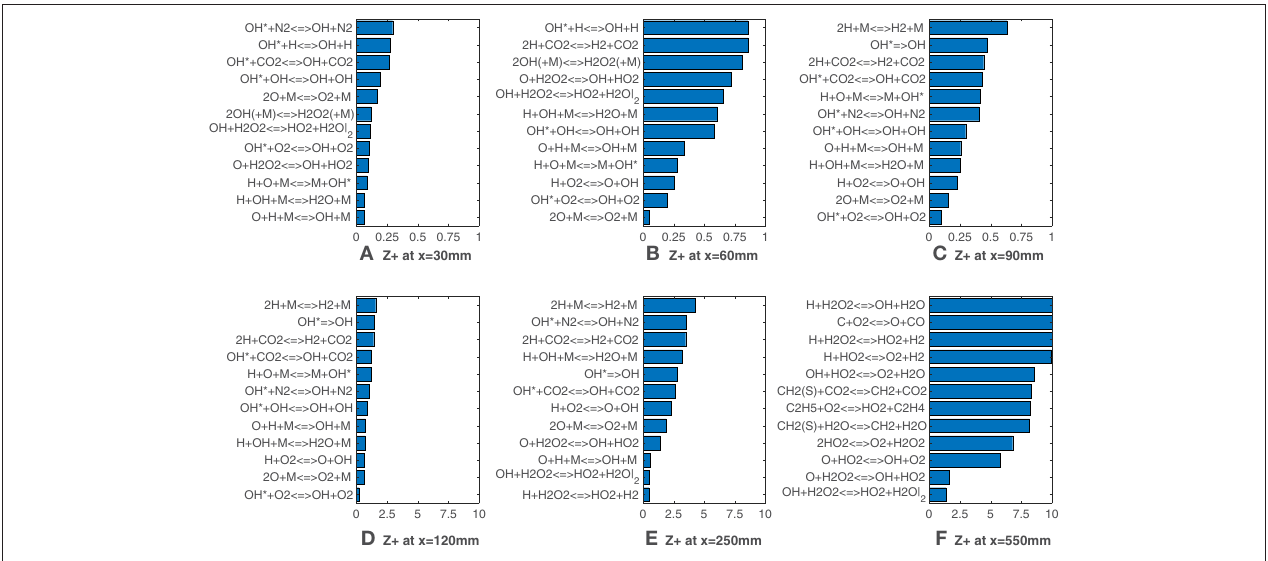
FIGURE 6 | HM3 case: best correlated net reaction rates at various axial locations. Lower Z + s ( ˙ ω r ) values mean better correlation.